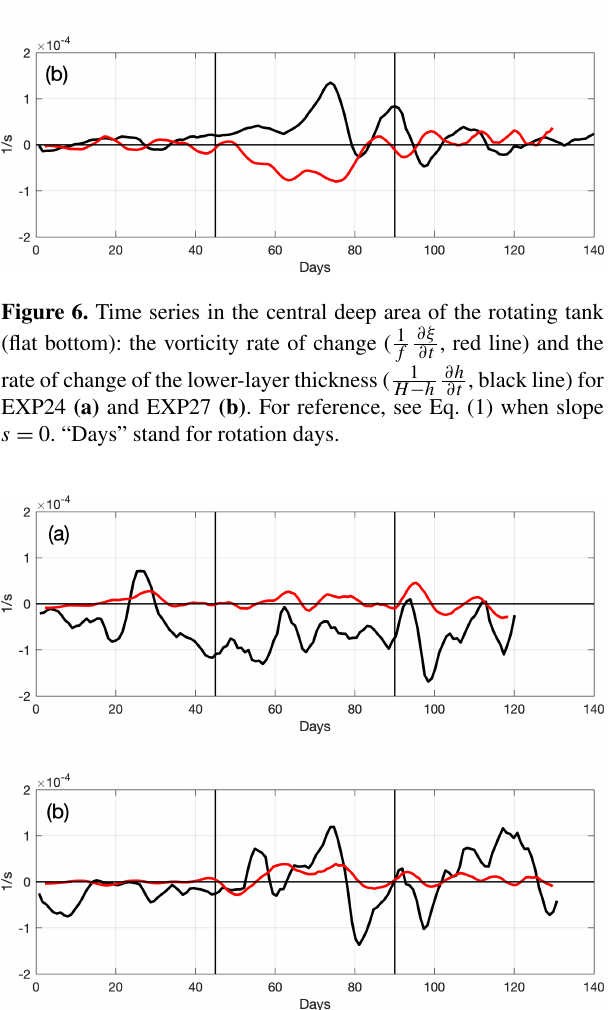
Figure 7. Time series in the slope area: the vorticity rate of change ∂ξ ( 1 , red line) and the sum of the rate of change of the lower-layer f ∂t thickness and the topographic β term ( 1 for EXP 24 (a) and EXP 27 (b) . For reference, see Eq. (1) when slope s = 0 . 1. “Days” stand for rotation